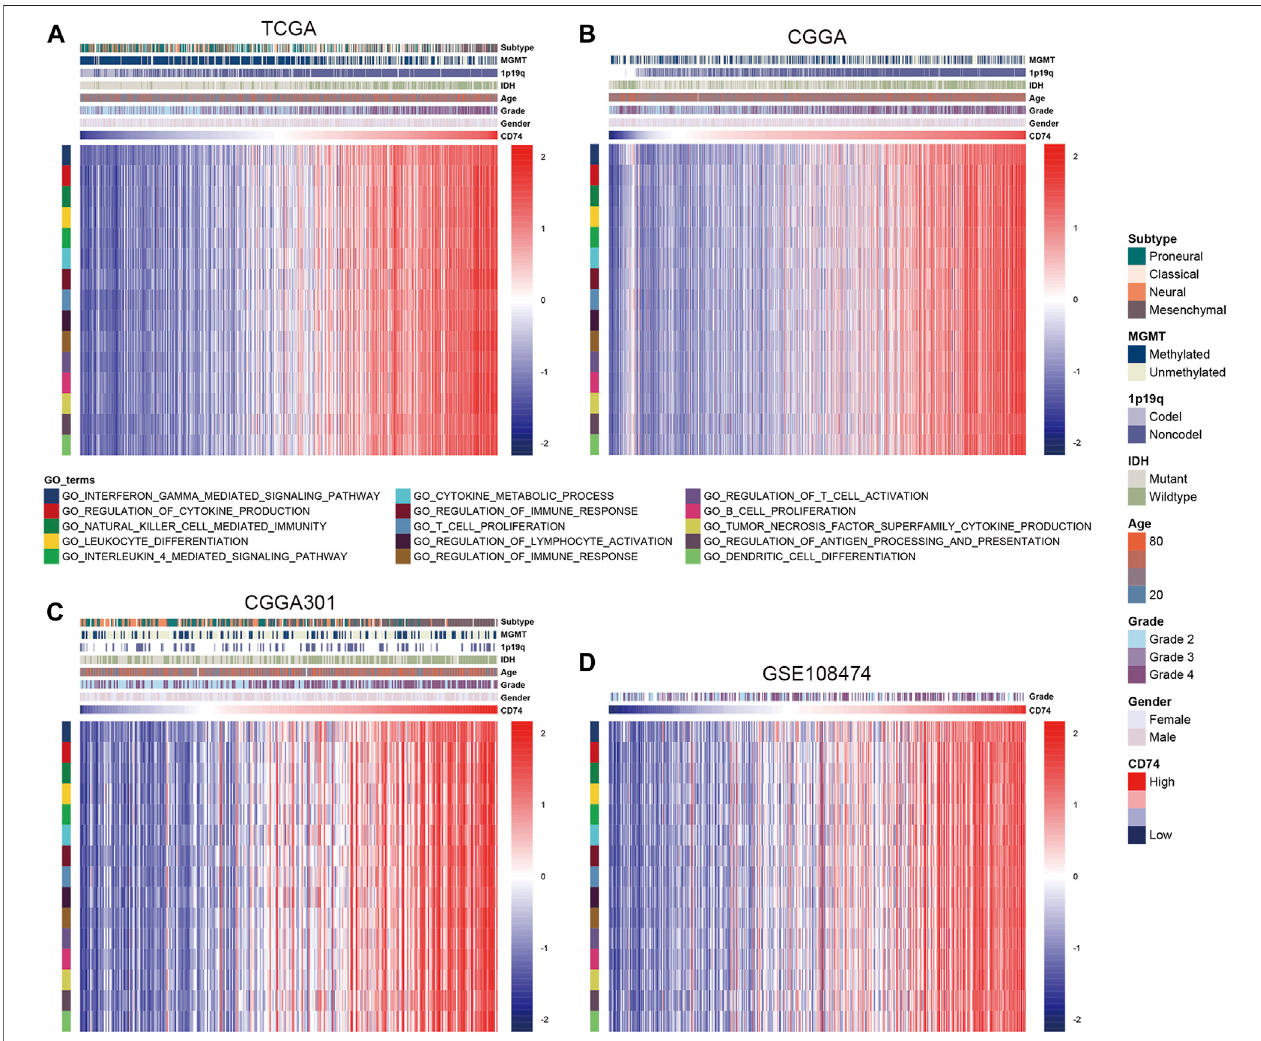
FIGURE 5 | Association between CD74 expression and immune processes. A-D. GSVA analyses revealed the association between the enrichment of immune processes and CD74 expression in the TCGA (A) , CGGA (B) , CGGA301 (C) , and GSE108474 (D) datasets. Red and blue represented relatively high and low involvement in each